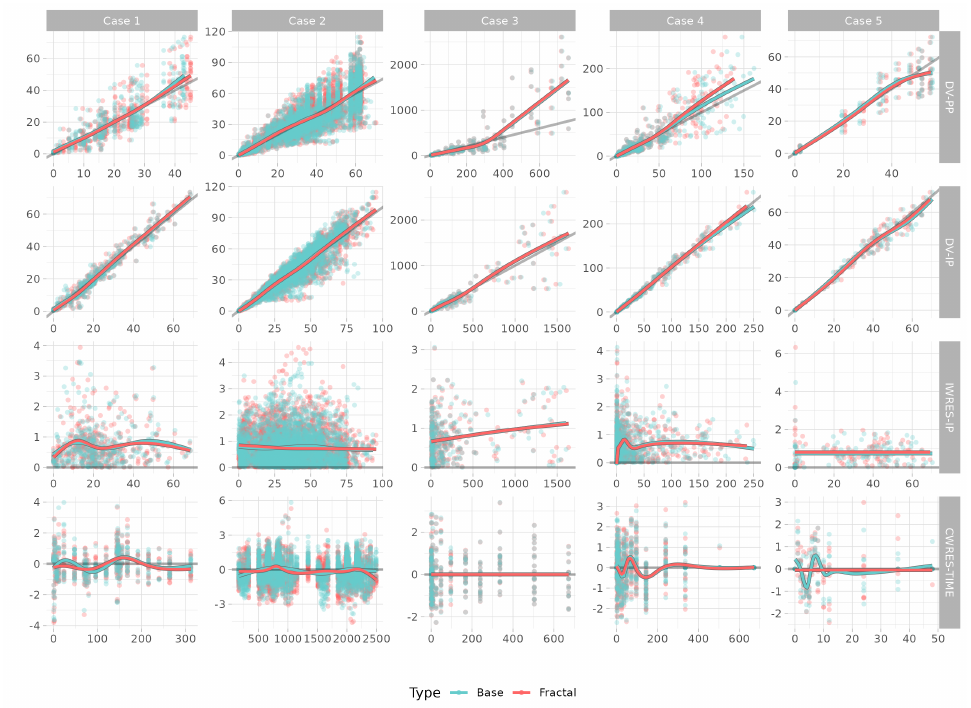
Figure 4. Overlain goodness of fit plots for the fractal and base models. Plots of the x and y axes are displayed in the label on the right side. DV: observation, PP: population prediction, IP: individual predictions, IWRES: individual weighted residuals, CWRES: conditional weighted residuals, TIME: time in hours.